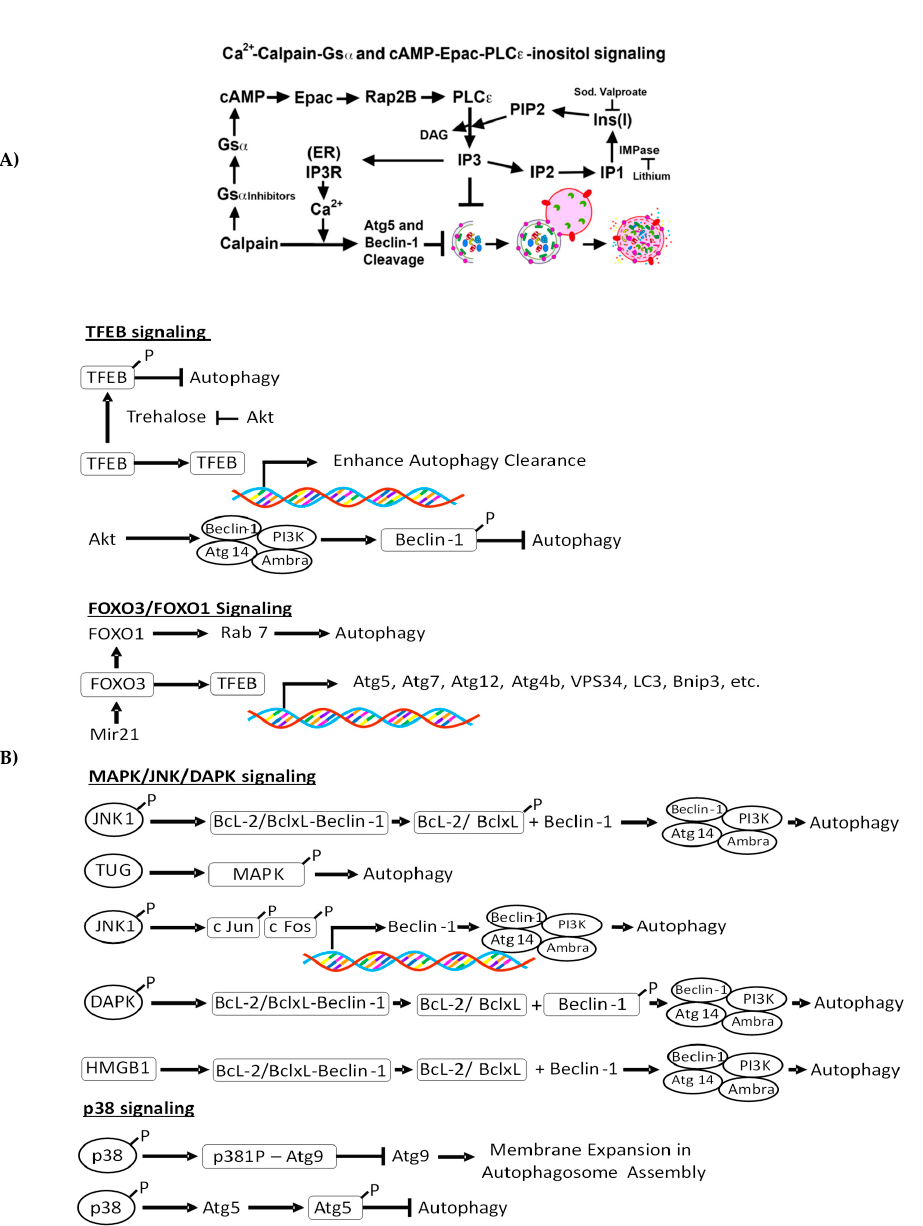
Figure 2. ( A ): Ca 2+ -calpain, cAMP- exchange protein directly activated by cAMP (Epac)- phosphoinositide-specific phospholipase C- ε (PLC- ε )-inositol phosphate 3 (IP 3 ) , and inositol signaling pathways of autophagy regulation. Calpains cleave α -subunit of G-protein (Gs α ) to from active Gs α (Gs α a ). Gs α a enhances adenyl cyclase activity to generate cAMP. The cAMP also regulates autophagy via a cAMP-Epac-PLC- ε -IP 3 pathway to generate Ins (1,4,5) P3 (IP 3 ), which inhibits autophagy in an mTOR-independent manner. Also, calpains activated by cytosolic calcium cleave autophagy proteins ATG5 38,39 and beclin-1 38 that can inactivate autophagy. ( B ): mTORC1-independent regulation of autophagy. TFEB-mediated autophagy induction: In response to renal IR injury, TFEB is translocated to the nucleus and induces lysosomal biogenesis and autophagy. Forkhead box O3 (FoxO3)-mediated autophagy induction: FoxO3 induces activation of TFEB, which upon translocation to the nucleus, transactivates autophagy genes. Also, FoxO3 induces FoxO1, which in association with Rab 7, facilitates the fusion of the lysosome to the autophagosome. Also, janus kinase (JNK), tether containing a UBX domain for GLUT4 (TUG), death-associated protein kinase (DAPK), and p38 regulate autophagy, as shown in the